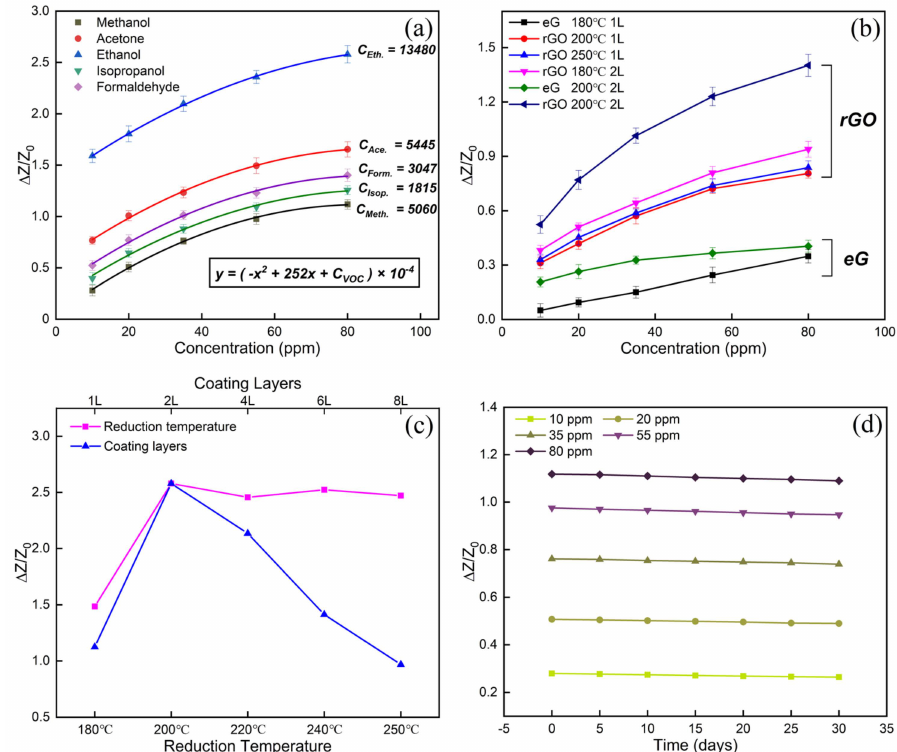
Figure 6. Sensing properties of the sensors constituting the multi-sensor array: ( a ) calibration curves of the sensor (rGO, 200 ◦ C, 2 L) in dependence on the VOCs concentrations; ( b ) calibration curves of each sensor characteristic vs. formaldehyde concentration; ( c ) effects of the number of coating layers and of the reduction temperatures on the relative response change at 80 ppm ethanol; and ( d ) long-term stability of the sensor (rGO, 200 ◦ C, 2 L) at a constant concentration of methanol (0–30